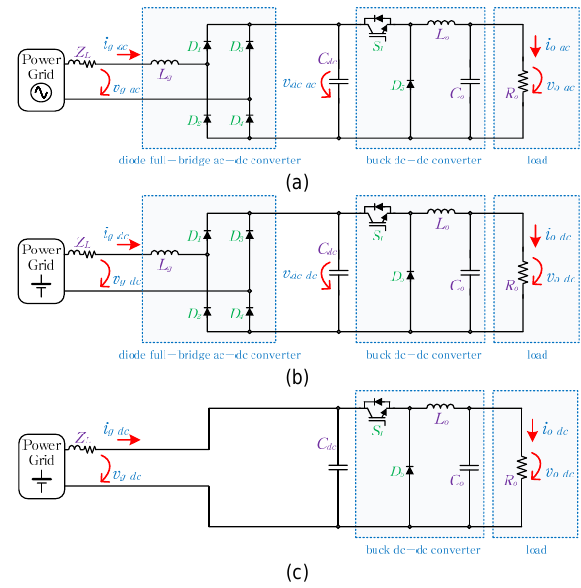
Figure 2. Considered cases for the analyzed nonlinear